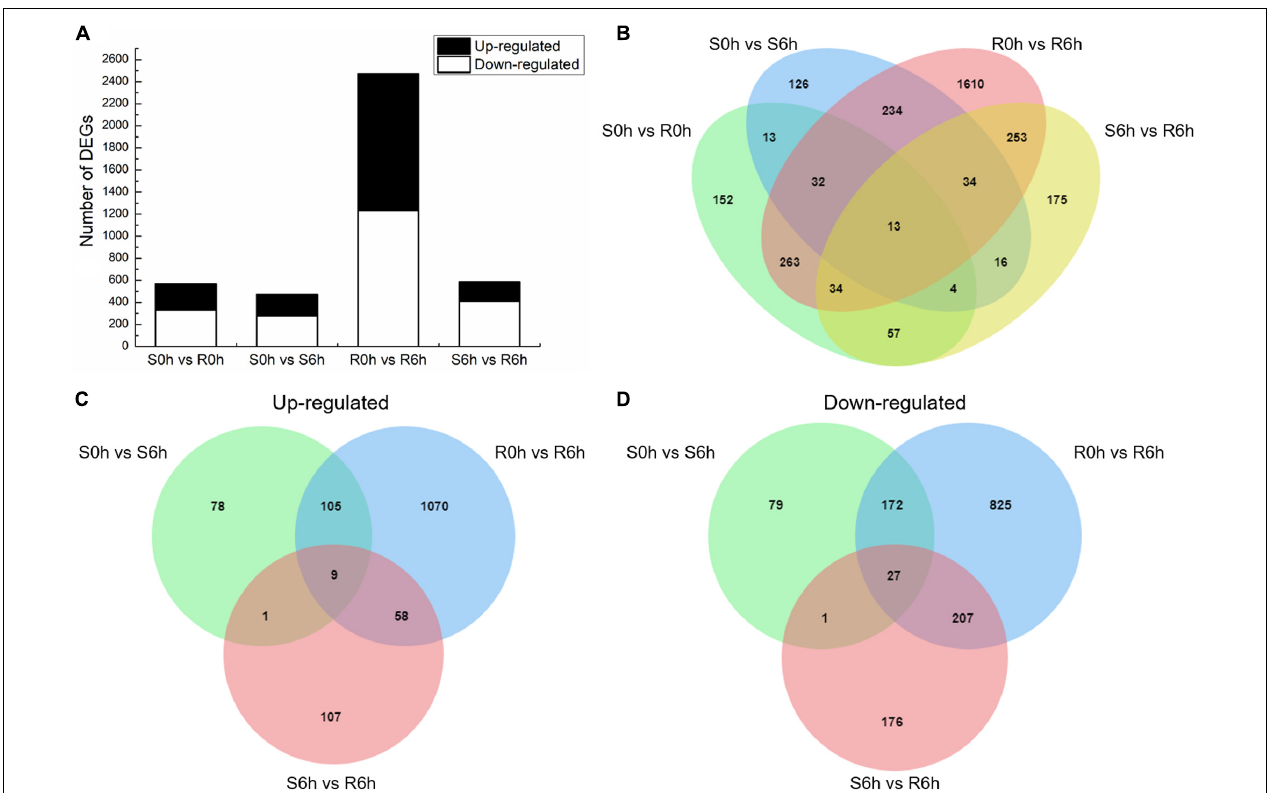
FIGURE 2 | DEGs between the PM-susceptible strain B21-a-2-2-2 (S) and PM-resistant strain B21-a-2-1-2 (R) of cucumber in response to P. xanthii . (A) Numbers of DEGs obtained in each comparison. (B) Overlap of DEGs in each comparison. (C) Venn diagram of genes up-regulated in S0h vs. S6h, R0h vs. R6h, and S6h vs. R6h comparisons. (D) Venn diagram of genes down-regulated in S0h vs. S6h, R0h vs. R6h, and S6h vs. R6h